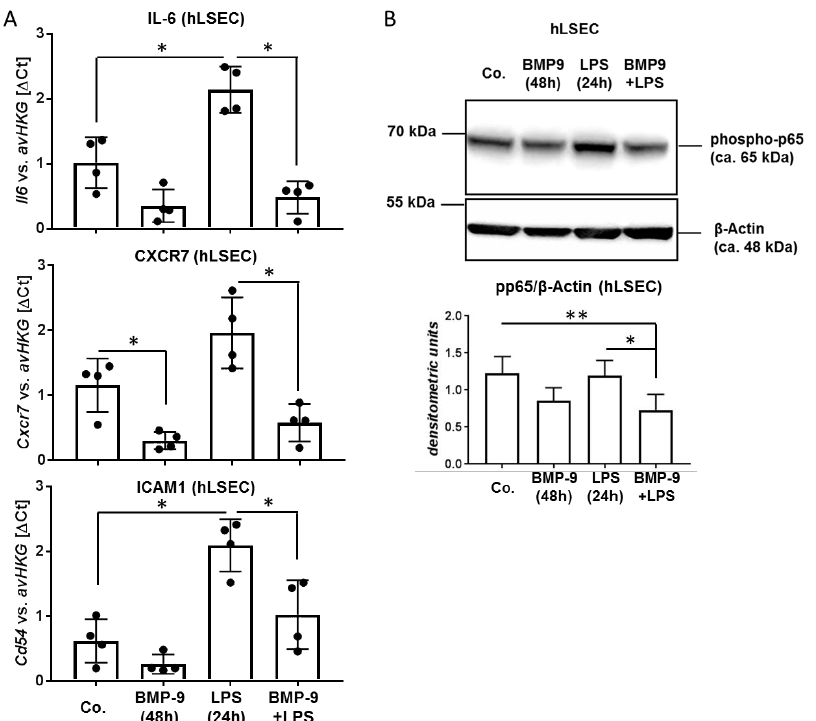
Figure 3. In human LSEC pre-treatment with BMP-9 antagonizes LPS-mediated activation of the NfκB pathway . ( A ) Human LSEC were pre-cultured with or without BMP-9 (5 ng/mL) for 24 h followed by addition of LPS (100 ng/mL) for another 24 h as indicated. Expression levels of IL-6, CXCR7 and CD54 were determined by RT-qPCR. Data are expressed as average values±SD (ΔCt of target gene versus house-keeping gene). ( B ) Using the same experimental setup as in ( A ) protein lysates of LSEC were subjected to Western blot analysis. Activation of the NfκB pathway was determined by detection of phosphorylated p65 and β-actin was used as loading control. One representative blot plus densitometric analyses results of n = 3 is shown. p < 0.05 was considered statistically significant (*). Each dot represents an individual sample’s value.